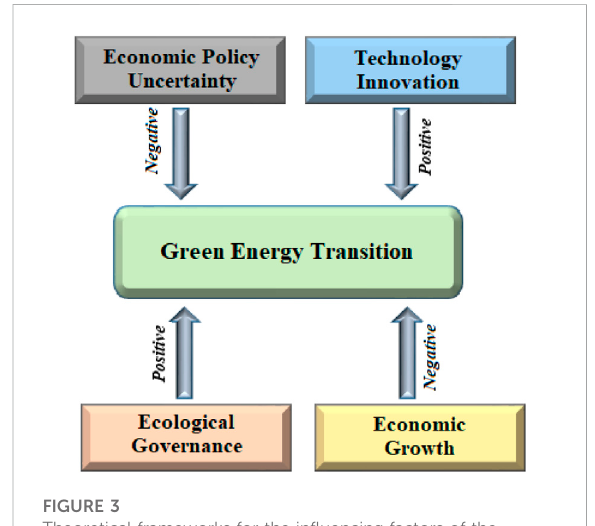
FIGURE 3 Theoretical frameworks for the in fl uencing factors of the green energy transition. Source: authors ’